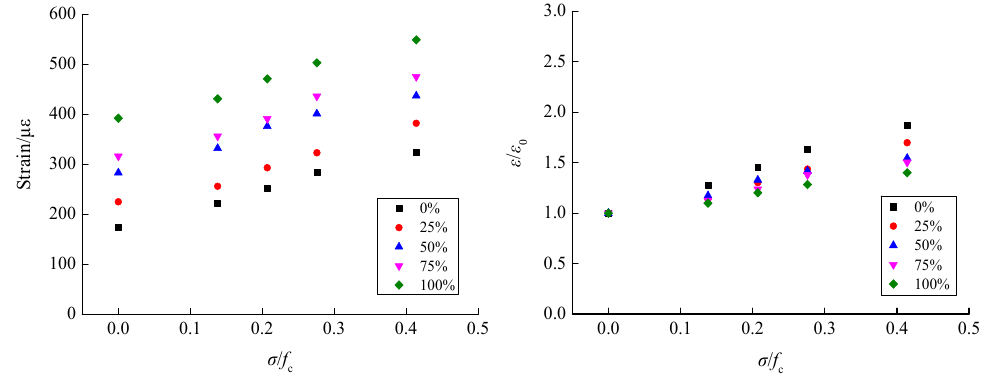
Figure 8. Variation trend of the influence of the axial compression ratio on the shear strain of recycled concrete.